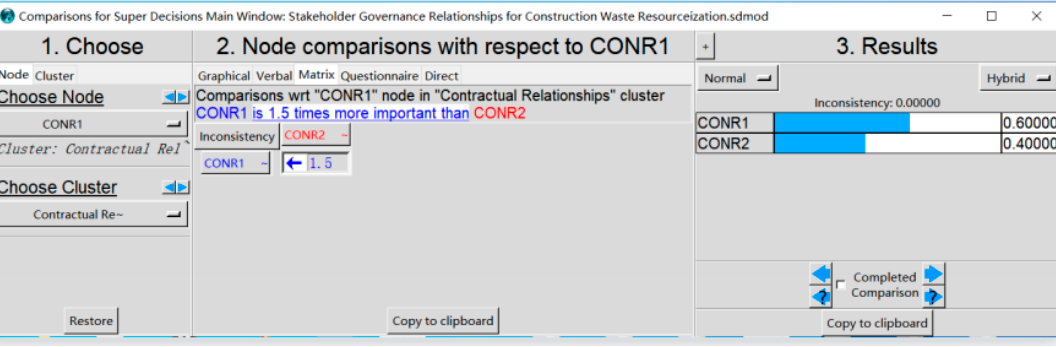
Figure 2. Pairwise comparison matrix of elements in HT set under H1 criterion.